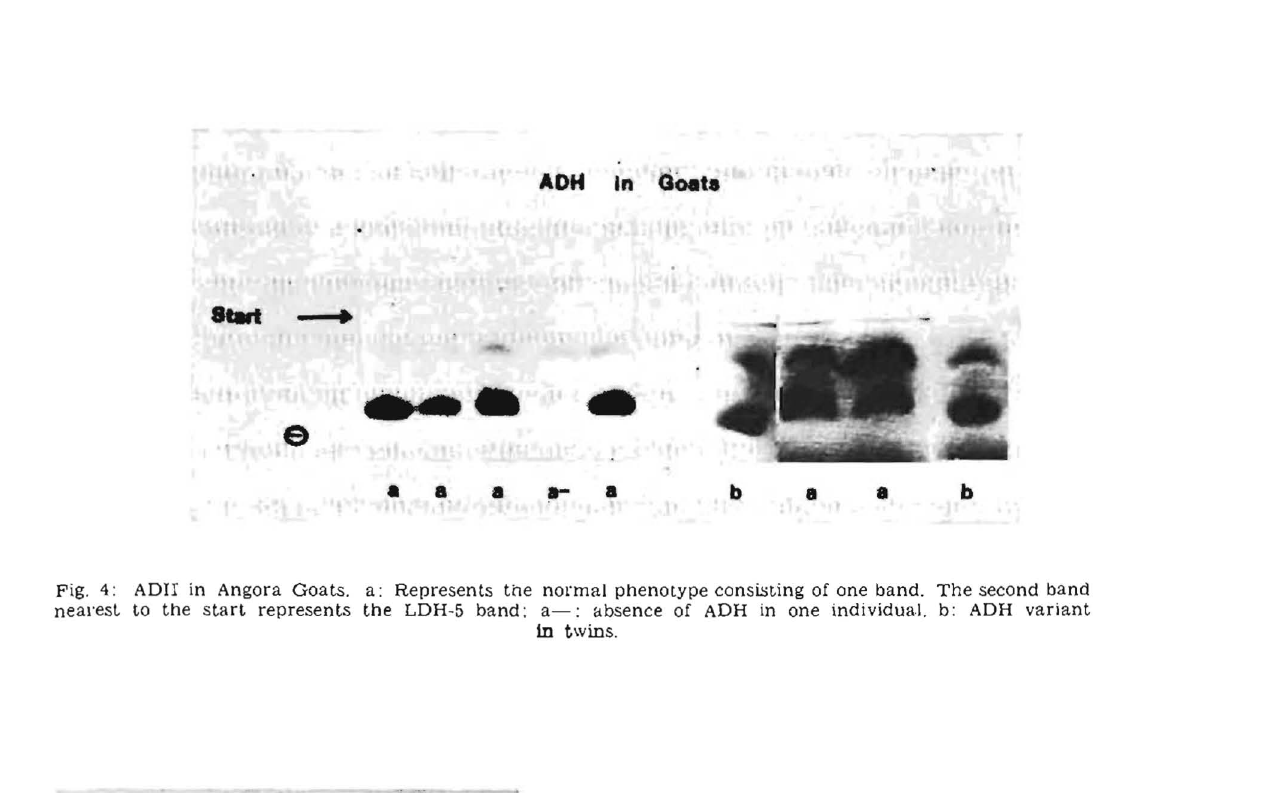
Fig, 4: ADII in Angora Goats, a: Represents the normal phenotype consi.sting of one band, The second band nearest to the start represents the LDH·5 band : a-: absence of ADH in one individual. b: ADH variant